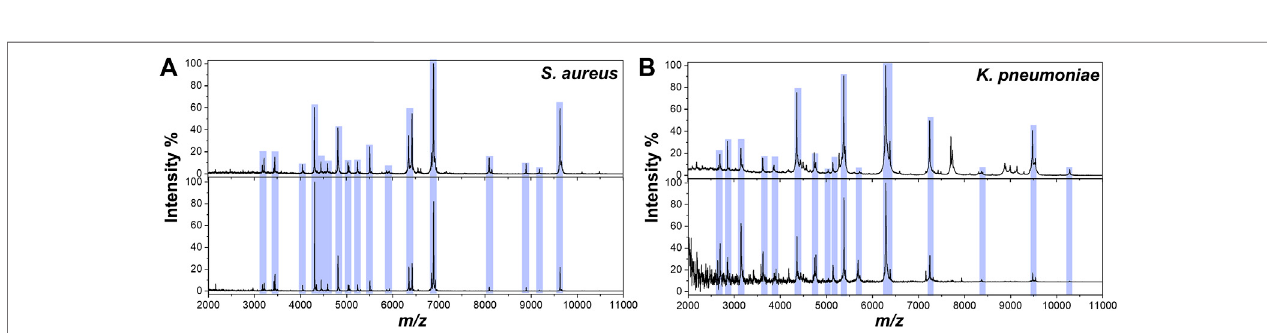
FIGURE 3 | MALDI-TOF MS spectra of (A) S. aureus and (B) K. pneumoniae obtained from pure solution (top) and enriched by Fc-MBL@Fe 3 O 4 from LB liquid media (bottom) .